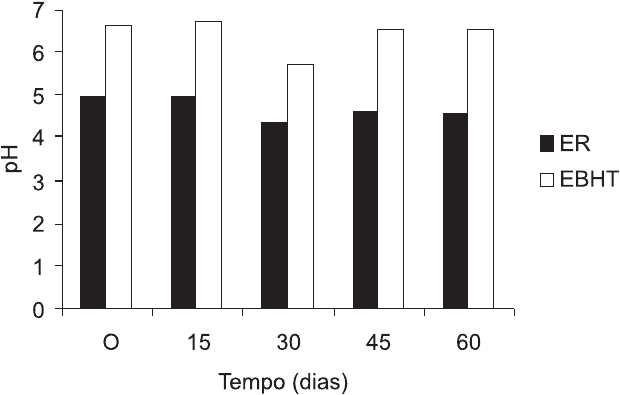
FIGURA 2 - Valores de pH da EBHT e ER armazenadas à 20° C em função do tempo de armazenamento